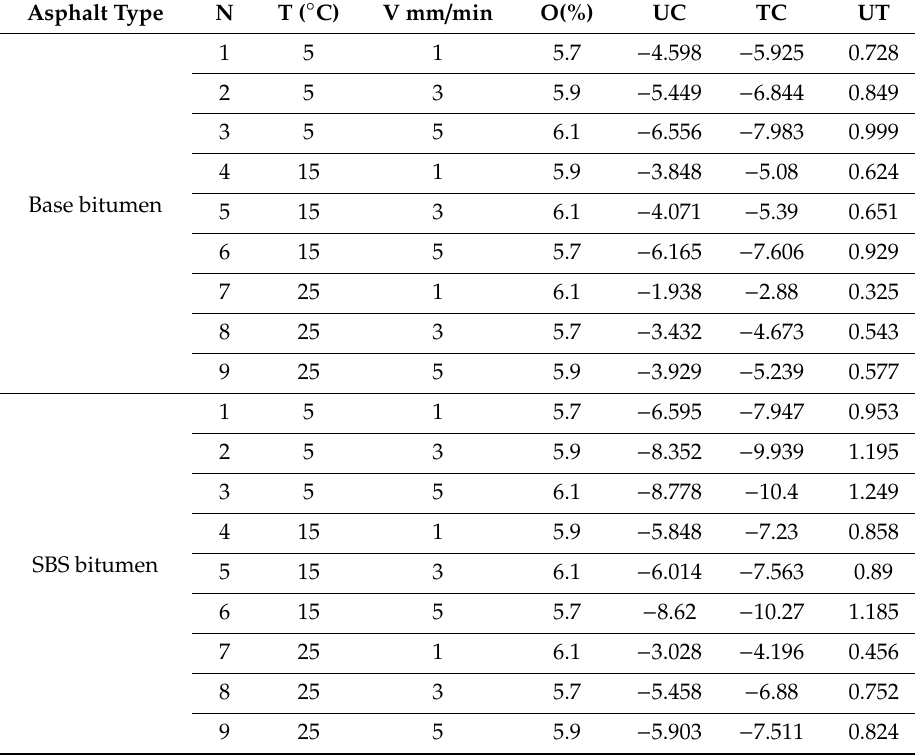
Table 12. Design plane of orthogonal test.